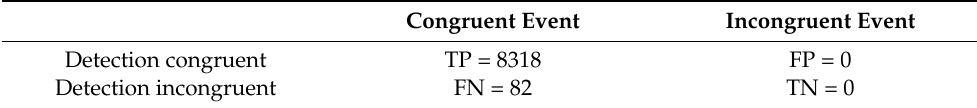
Table 10. Contingency table that assists with the detection of congruences in the Landsat 8 scene of the Doce River basin acquired in 2018 and consisting of 8400 tiles (TP—true positive, FP—false positive, FN—false negative, TN—true negative).